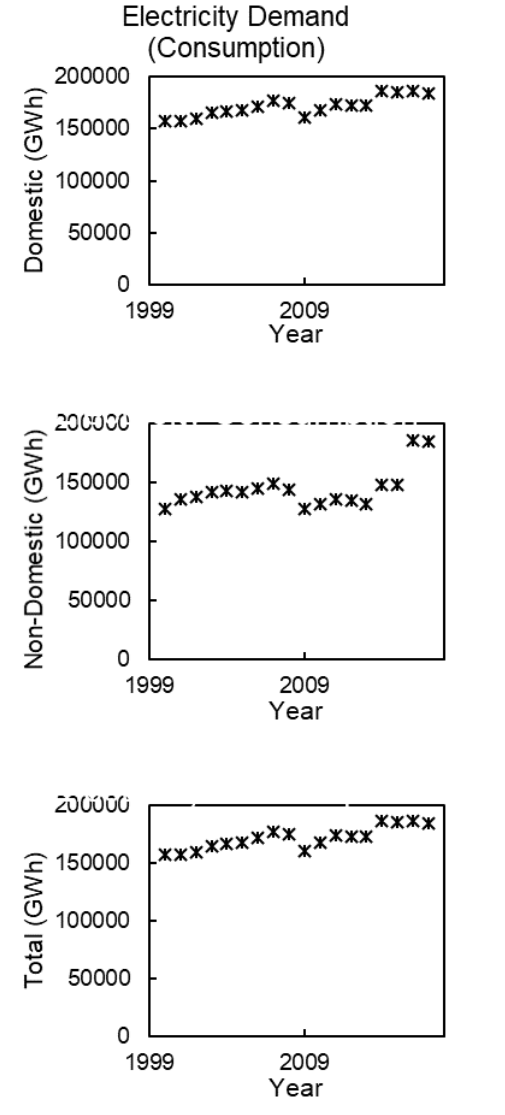
Figure 2: Dynamics of the changed values of explanatory variables and electricity demand,